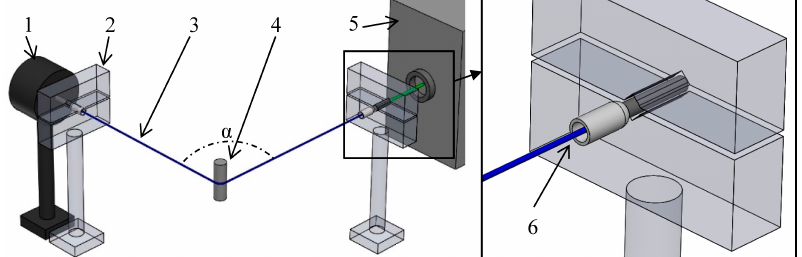
Figure 1. Measurement layout (1—light power meter, 2—clamp, 3—reinforcing fiber bundle, 4—bending, 5—light source, 6—cord ‐ end terminal).